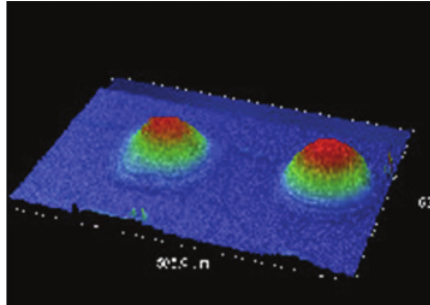
Figure 2: A typical optical